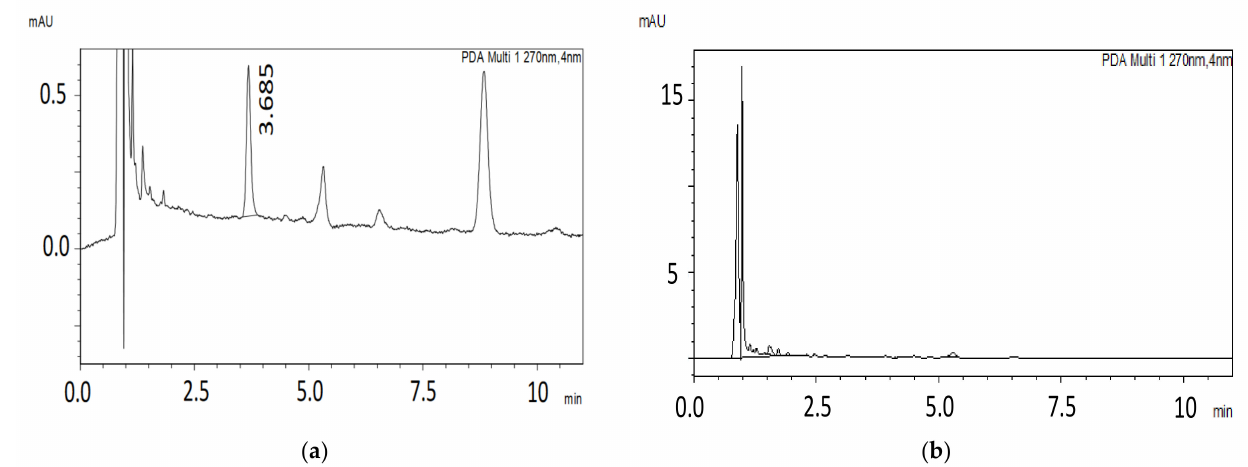
Figure 4. Representative chromatograms of ( a ) HLM sample spiked with capmatinib (t R = 3.68 min) at LLOQ level 206 ng/mL at wavelength of 270 nm and ( b ) blank HLM sample at wavelengths of 270